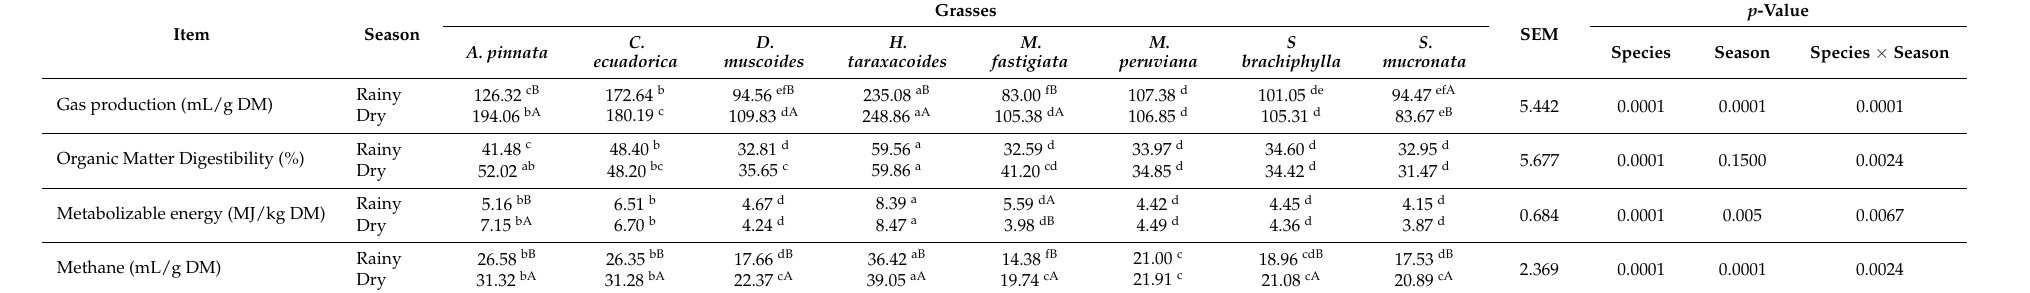
Table 2. Gas production, in vitro digestibility, metabolizable energy and enteric methane production of natural grasses in rainy and dry